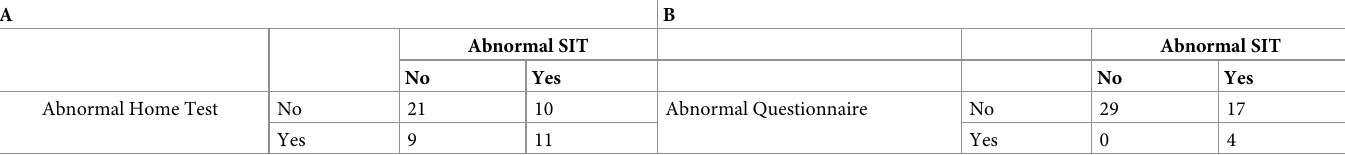
Table 5. Results of SIT testing compared with home odorant-based testing and questionnaire results. A. Test results were considered abnormal if patients were diag- nosed with any degree of microsmia or anosmia on SIT, or if any question on home-based testing was incorrect. B. Test results were considered abnormal if patients were diagnosed with any degree of microsmia or anosmia on SIT, or if they reported “Yes” to questions asking about change in sense of smell or taste in the past 14